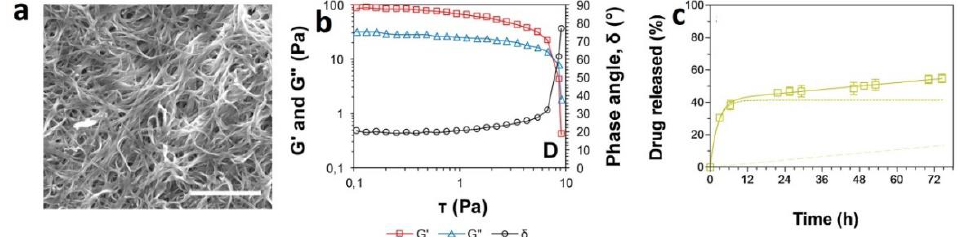
Figure 4. ( a ) SEM images of xerogels of 1 · methotrexate. Scale bar represents 10 µ m. ( b ) Elastic modulus (G ′ ), loss modulus (G ″) and phase angle (δ ) as a function of shear stress. ( c ) In vitro drug released (%) along time from gels. Drug release in all cases followed a Two-Phase Exponential Association model. The first phase release is shown in dotted line, the second phase release is shown in dashed line, and the cumulative amount of drug released from both phases is shown in continuous line. [115]. Reprinted with the permission from Colloids and Surfaces B: Biointerfaces. Copyright Elsevier, 2019.